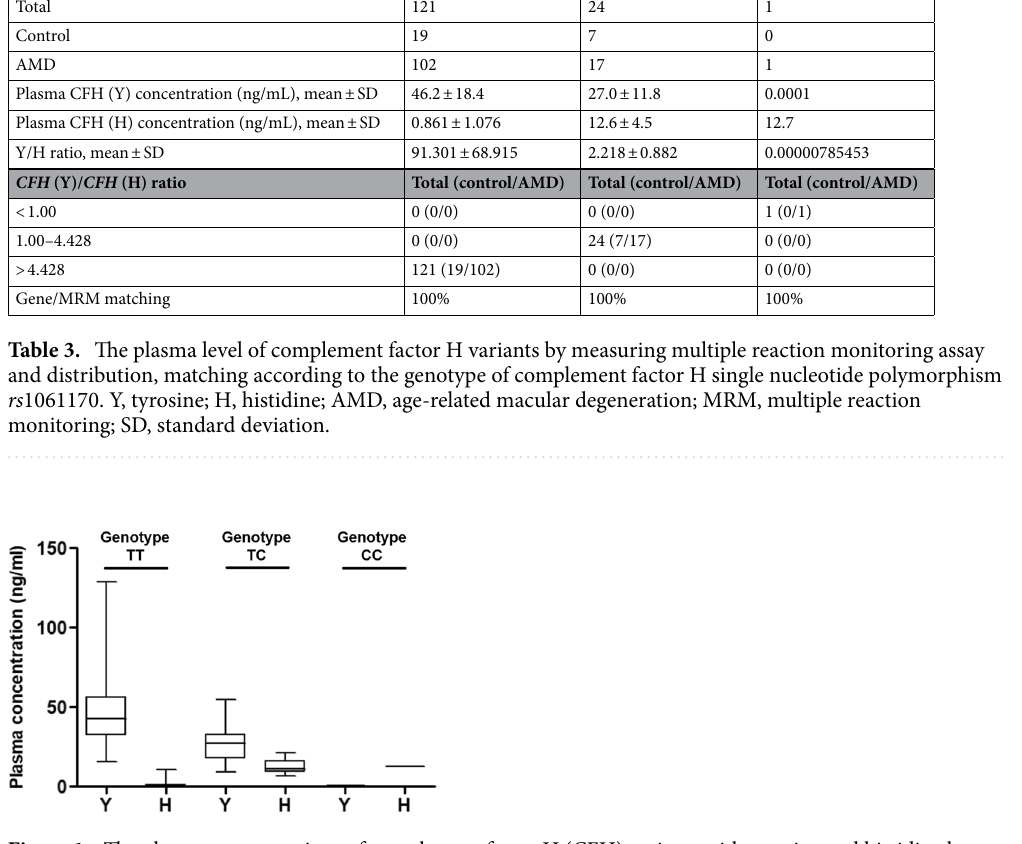
Figure 1. The plasma concentrations of complement factor H (CFH) variants with tyrosine and histidine by measuring multiple reaction monitoring assays according to CFH single nucleotide polymorphism rs 1061170. Y, tyrosine; H,